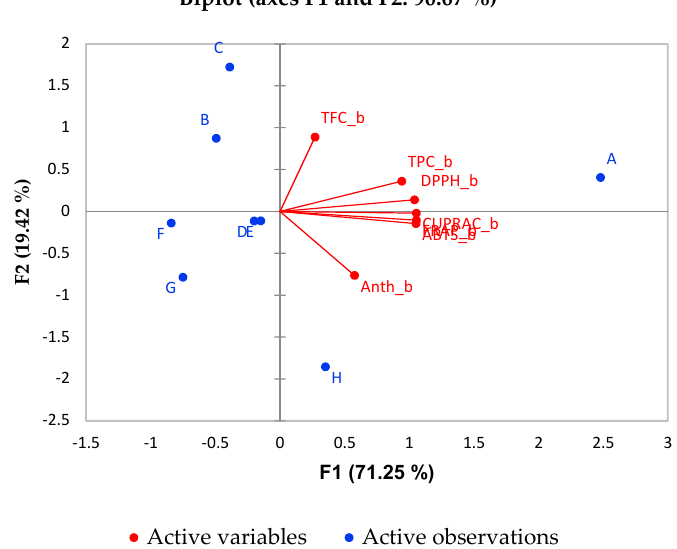
Figure 3. Biplot of for PCA analysis of fruit juices.